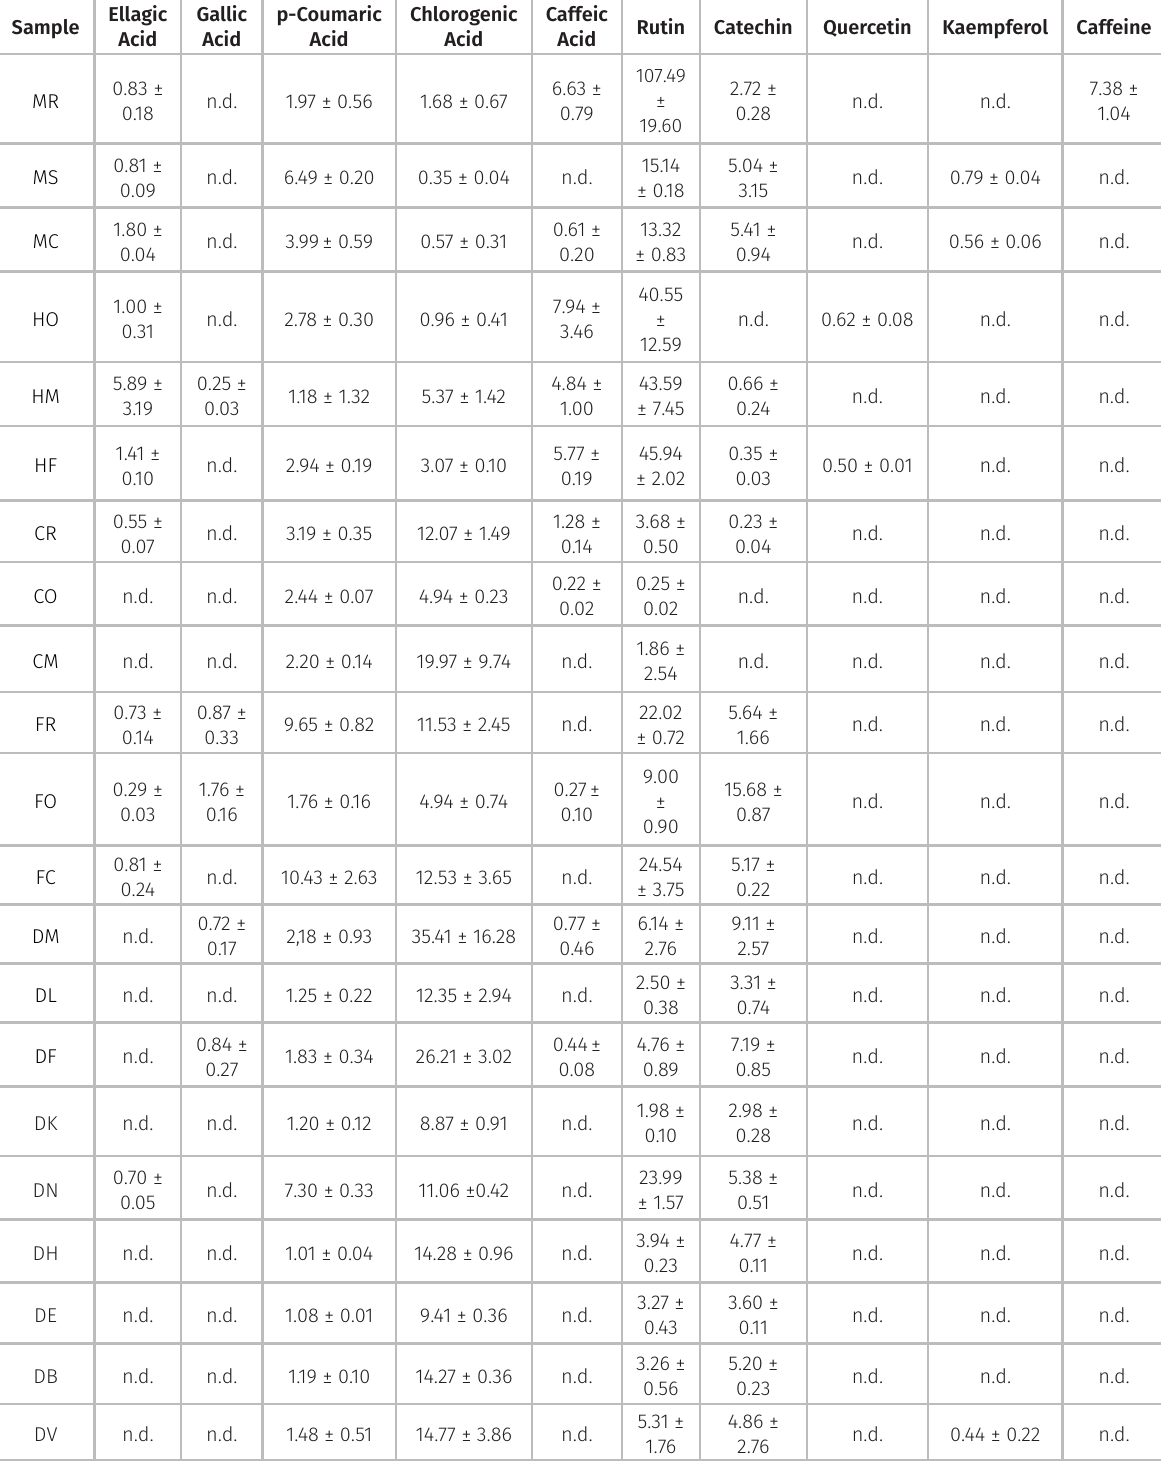
Table V. Concentration (mg L -1 ) of phenolics and caffeine in infusions. Sample